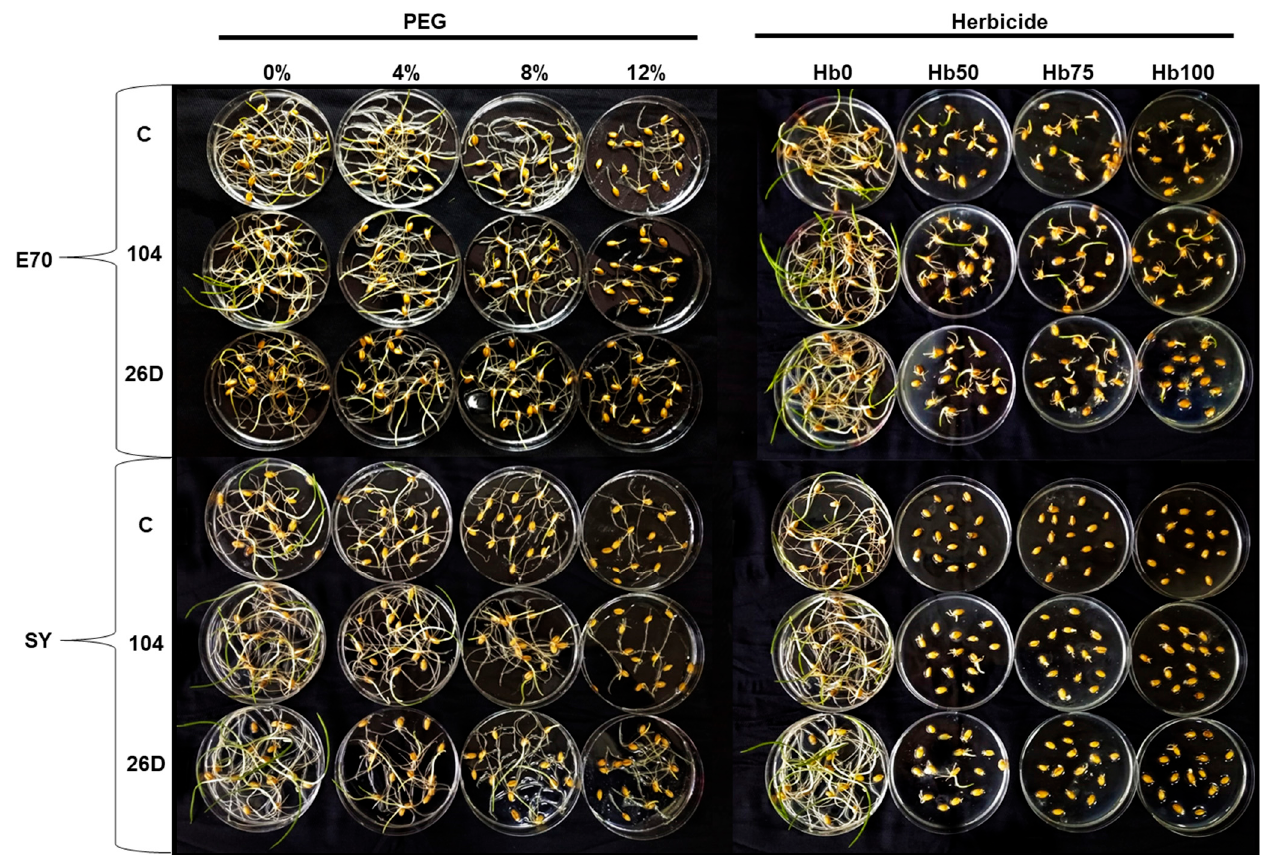
Figure 2. Effects of different concentration of herbicide Sekator ® Turbo (0 mL L − 1 (Hb0), 0.25 mL L − 1 (Hb50), 0.375 mL L − 1 (Hb75), 0.5 mL L − 1 (Hb100)), and drought (PEG) (0%, 4%, 8%, 12%) stresses on bacterial (strains 104 and 26D) inoculated seed germination in wheat after 7 days of treatments. Seed priming with B. subtilis 104 and 26D in different levels decreased (by 40–50%)